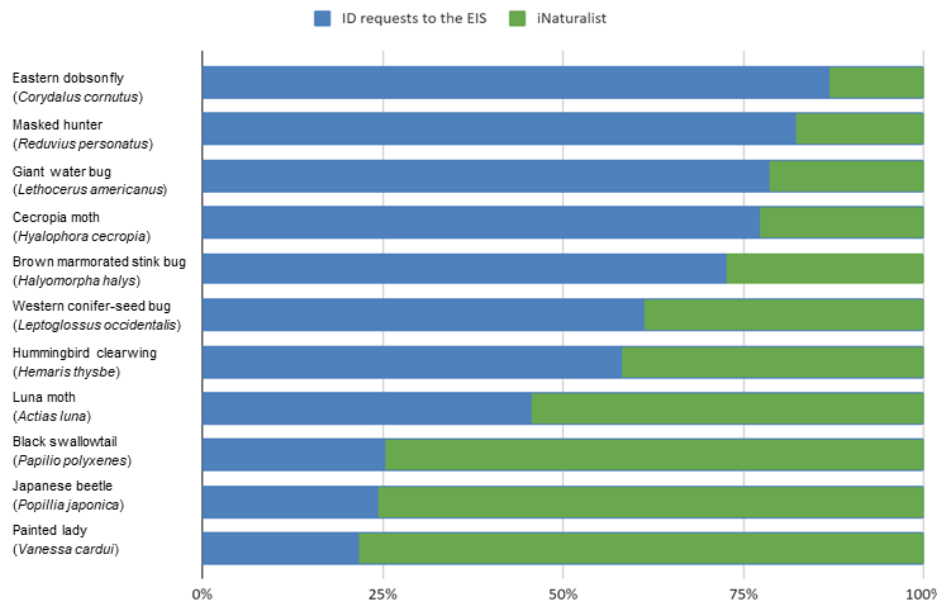
Figure 4. Comparison of the relative number of requests submitted to the Insectarium’s Entomological Information Service with observations submitted to iNaturalist for the province of Québec during 2010, 2011, 2017, and 2018.